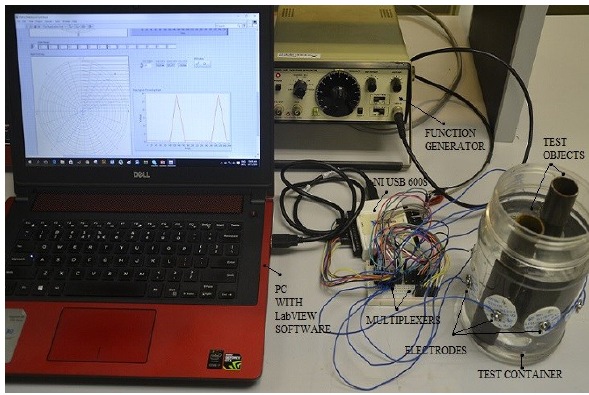
Fig. 2: Complete experimental set up of the proposed study. The test objects are placed at electrode positions 4 and 8